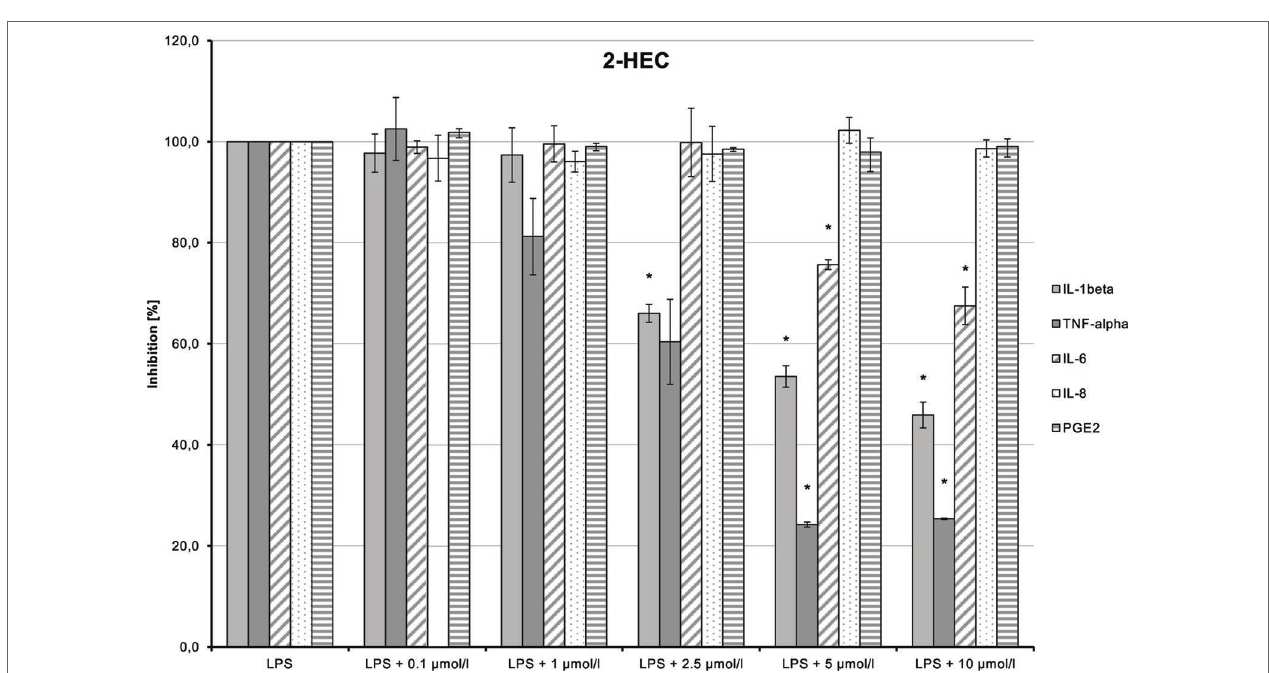
FigURE 10 | Anti‑inflammatory effect of 2‑hydroxyethyl cannabidiolate (2‑HEC) on primary human monocytes; normalized to the induction by lipopolysaccharide (LPS) (without the addition of test compounds); n = 2 independent experiments; error bars show SEM, * p < 0.1.